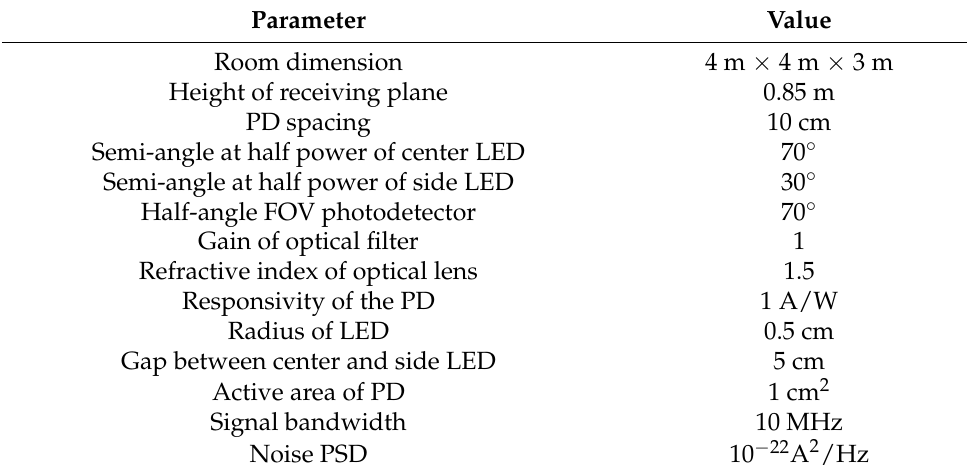
Table 1. Simulation